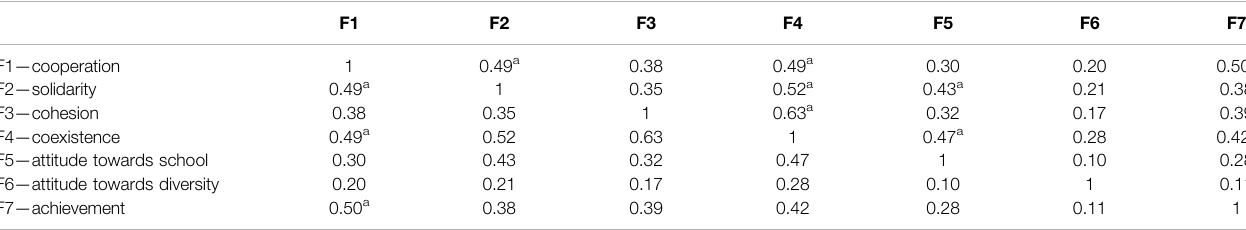
TABLE 5 | Analysis of